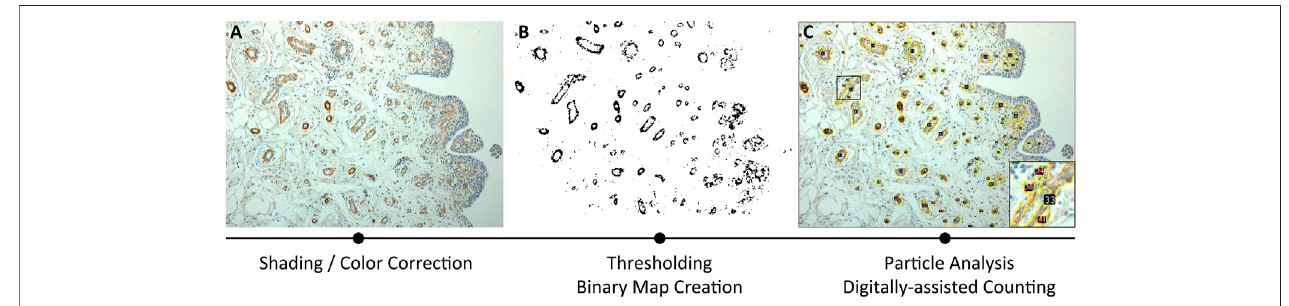
FIGURE 1 | Methodological approach for Piezo receptors morphometrical analysis, based on immunoreactivity. The three consequential steps include: (A) shading/color correction of the image; (B) thresholding through binary map creation; (C) particle analysis by digitally assisted counting.